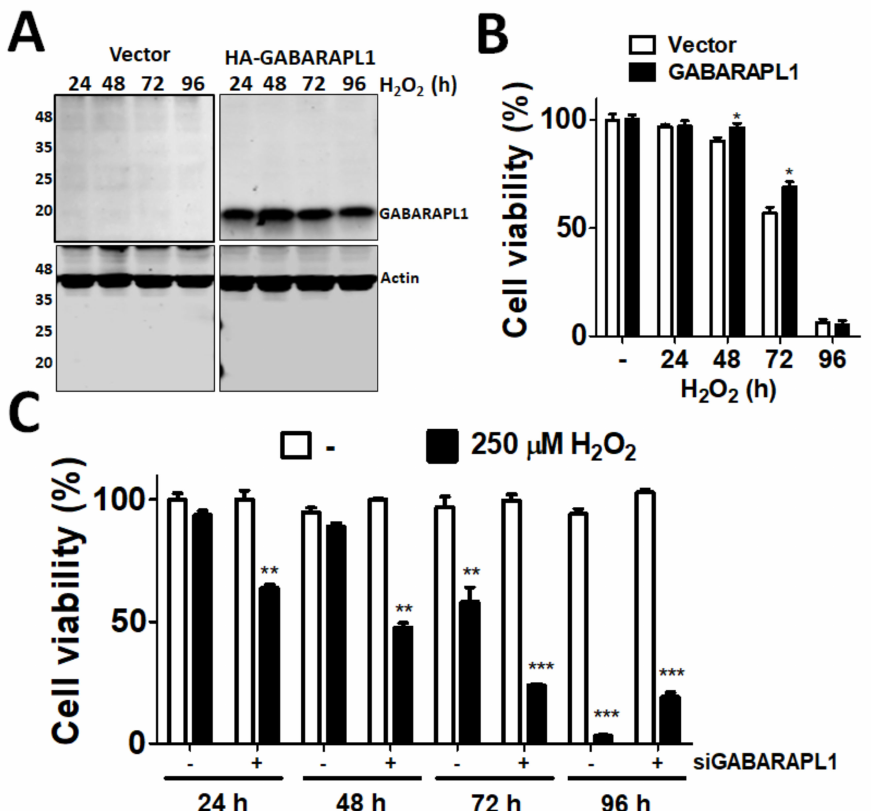
Figure 3. The effects of GABARAPL1 on ARPE-19 cell viability during oxidative stress. ( A ) Human ARPE-19 cells were transfected blank vector or vector encoding HA-GABARAPL1 and treated with H 2 O 2 (250 µ M) for 24, 48, 72, and 96 h. The protein levels of GABARAPL1 and Actin were determined by immunoblotting. Molecular weight is shown in the left-hand side of the blot. ( B ) The cells viability was examined by a Cell-titer Glo ® Assay System. ( C ) ARPE-19 cells were transfected 5 nM of off- targeting siRNA ( − ) or siRNA against GABARAPL1 ( + ) and exposed to H 2 O 2 (250 µ M) for 24, 48, 72, and 96 h. Cell viability of the cells was measured with a Cell-titer Glo ® Assay System. The data were analyzed with Prism 5, and the results are shown as the mean ± SEM from three independent experiments. ** p < 0.01, *** p < 0.001 siGABARAPL1 vs. non-targeting control siRNA